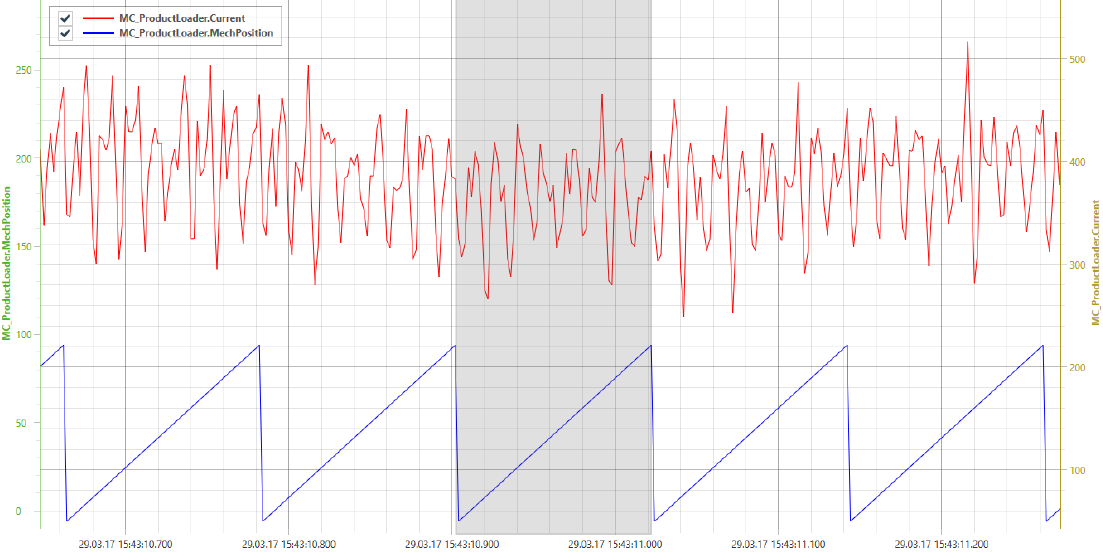
Figure 15. Correlated period of two sensor